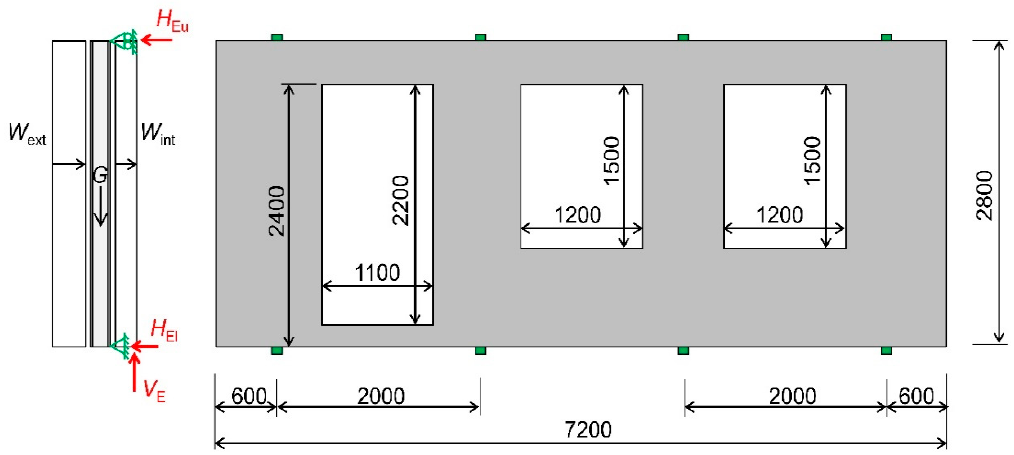
Figure 1. Illustration of sandwich element concept with structural loads (wind and self-weight, in black) and reaction forces (horizontal and vertical, in red).